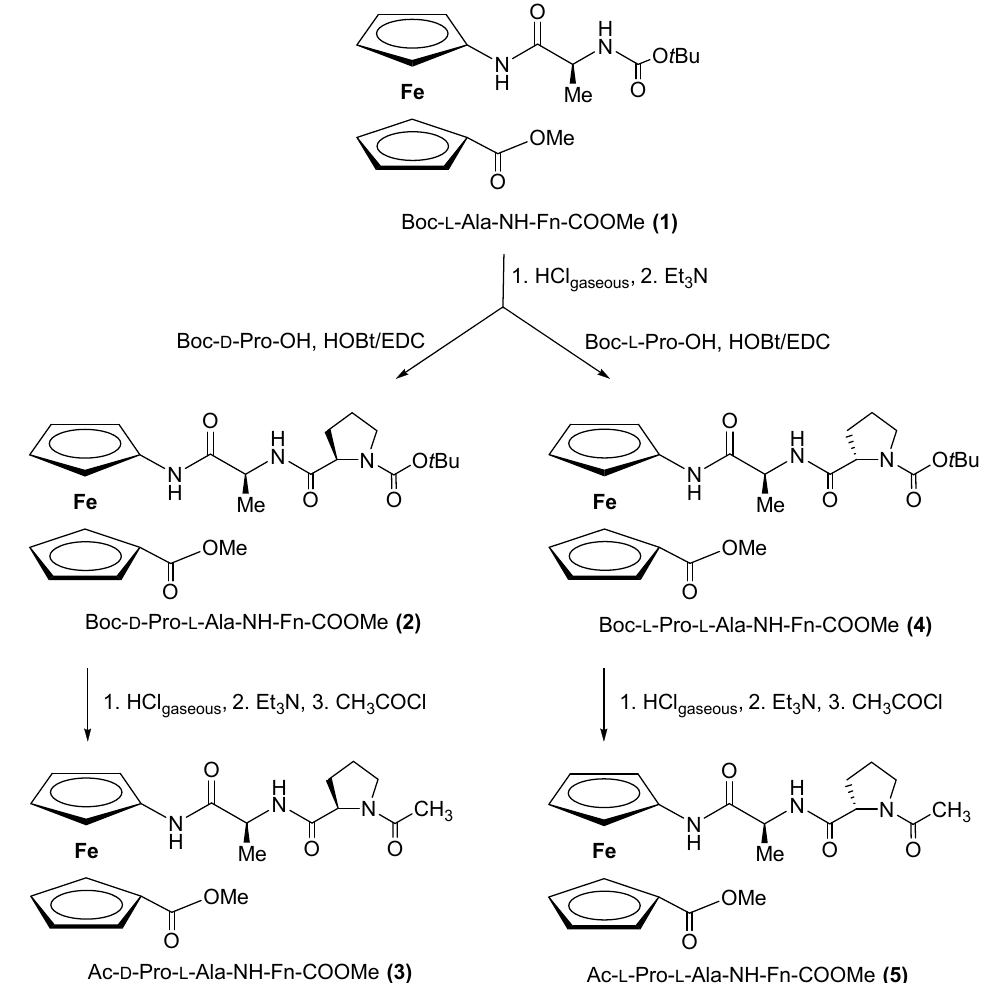
Scheme 1. Synthesis of Boc-( 2 , 4 ) and Ac-protected peptides ( 3 , 5 ) containing homo-and heterochiral Pro-Ala